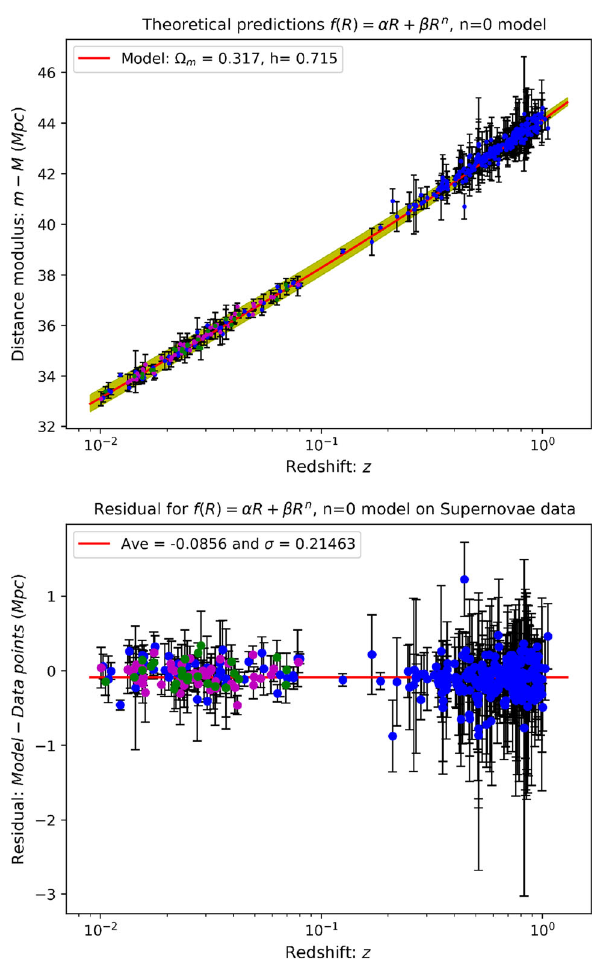
Fig. 4 The second toy model (with n = 0) fitted to the Supernovae Type 1A data. With cosmological parameter values calculated by the (unreliably constrained) MCMC simulation as Ω m = 0 . 317 + 0 . 061 − 0 . 101 km (unconstrained), while the arbitrary free and H 0 = 71 . 5 + 6 . 0 − 7 . 2 s . Mpc (constrained) and parameters were calculated to be α = 1 . 202 + 0 . 397 − 0 . 392 β = − 5 . 265 + 1 . 698 − 1 . 315